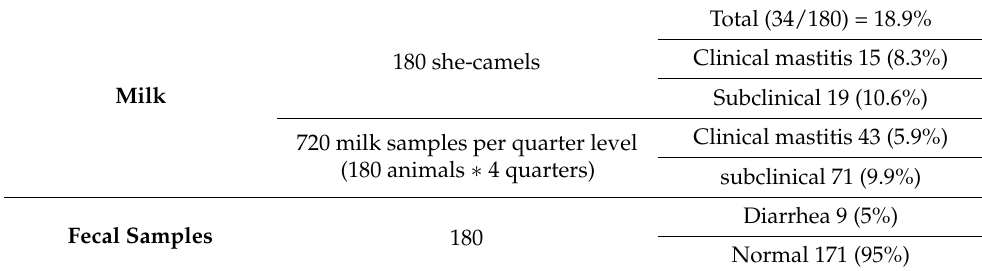
Table 1. Occurrence of clinical and subclinical mastitis in she-camel.